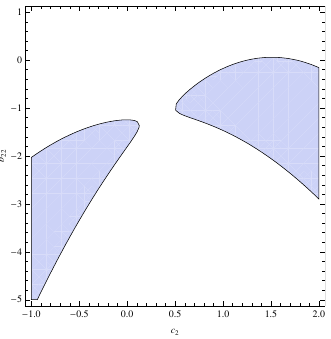
Figure 2. Region of algebraic stability for TSRK methods (4.4) with p = q = s = 2 and real-valued coefficients.